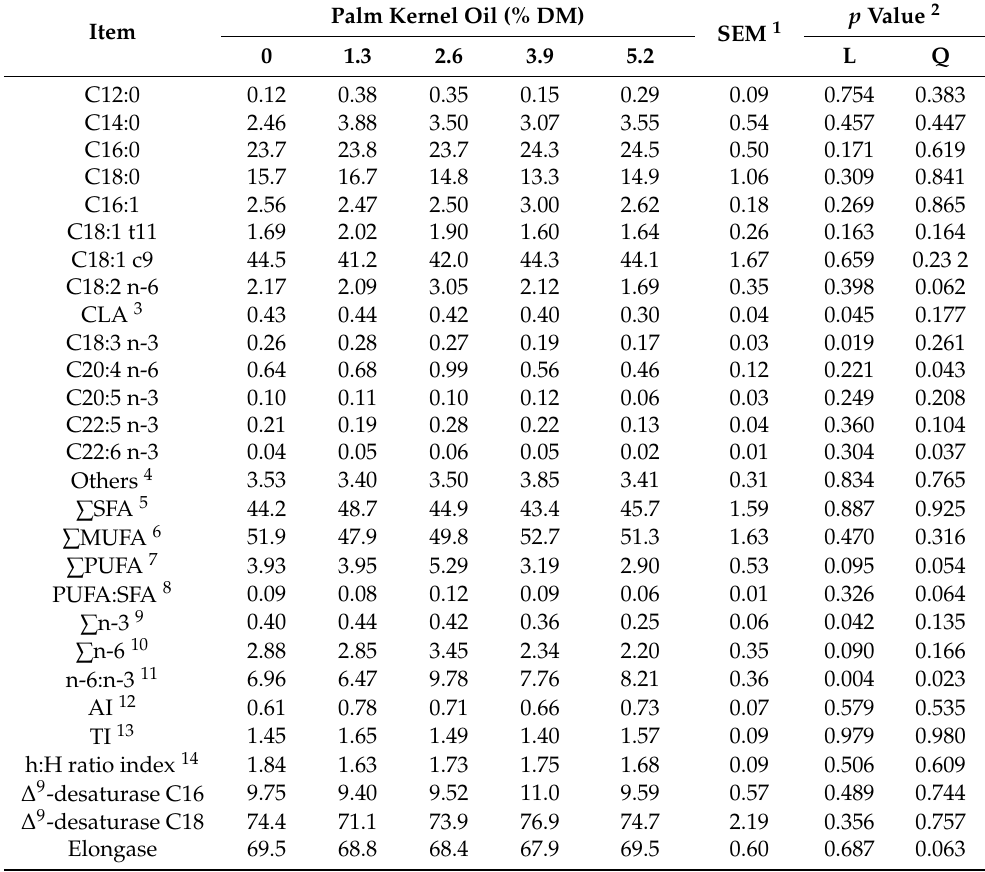
Table 4. Fatty acids profile (% FAME) of Longissimus lumborum muscle of the lambs’ fed diets with different levels of palm kernel